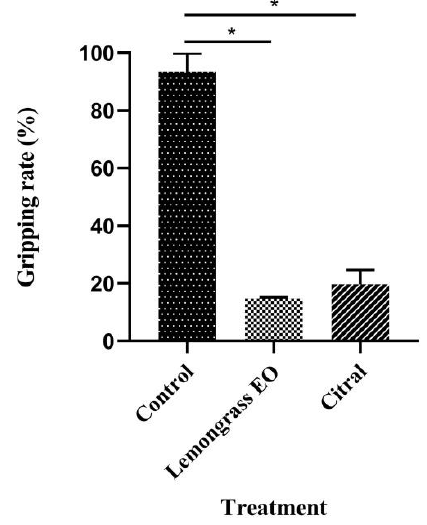
Figure 2. Effect of lemongrass EO and its major constituent on the gripping behavior of R. flaviceps workers. Mean ( ± SD) values with * show significant differences ( p < 0.01), according to Tukey’s HSD test.